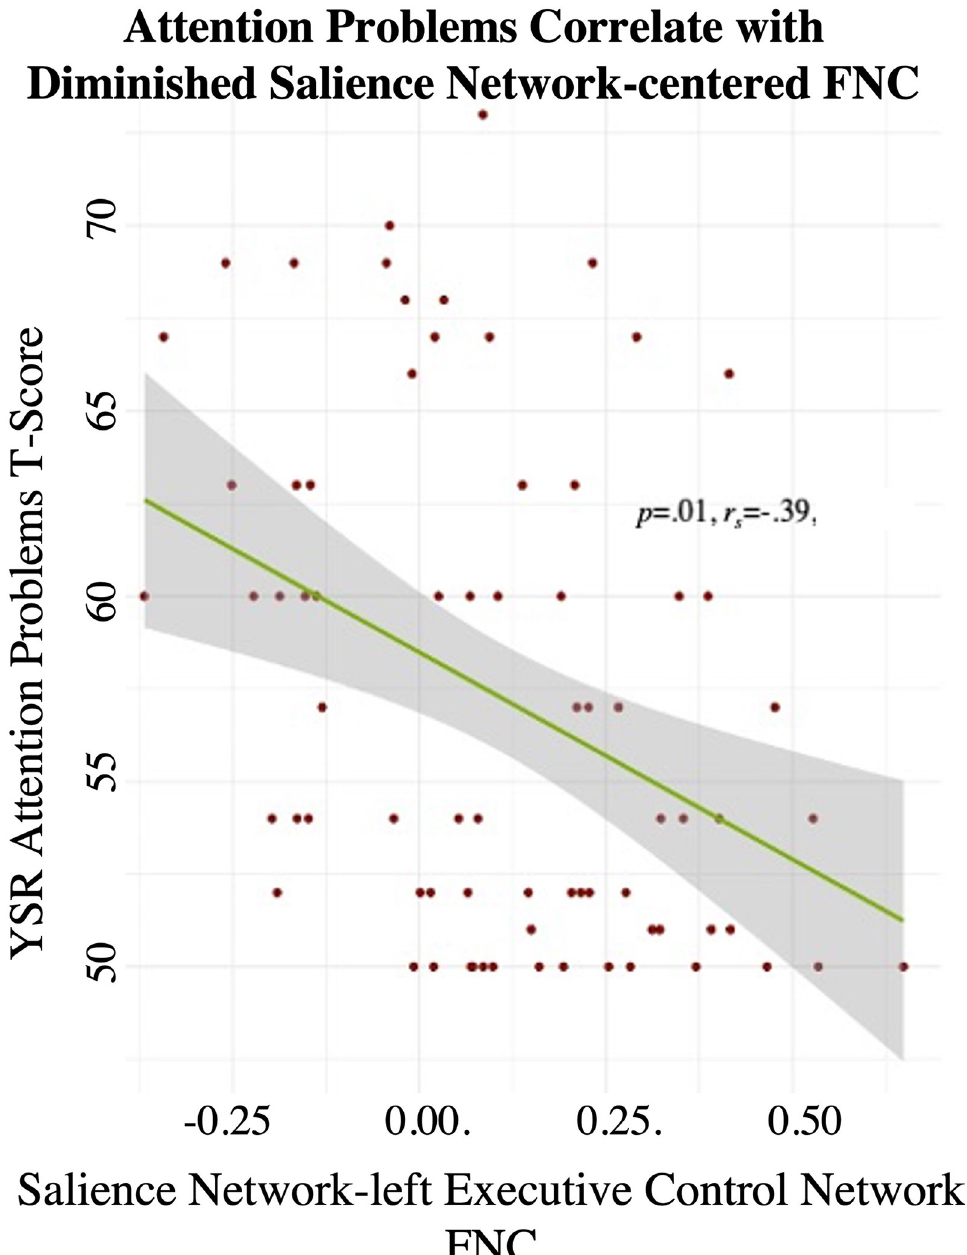
Fig 3. Association between FNC in dynamic state-1 and attention problems. Pearson correlations revealed that participants’ T-Scores for Attention Problems (as measured by the YSR) correlated with diminished functional connectivity between the Salience Network and the left Executive Control Network during Dynamic State-1 (No other correlations survived correction for multiple comparisons (FDR; p <